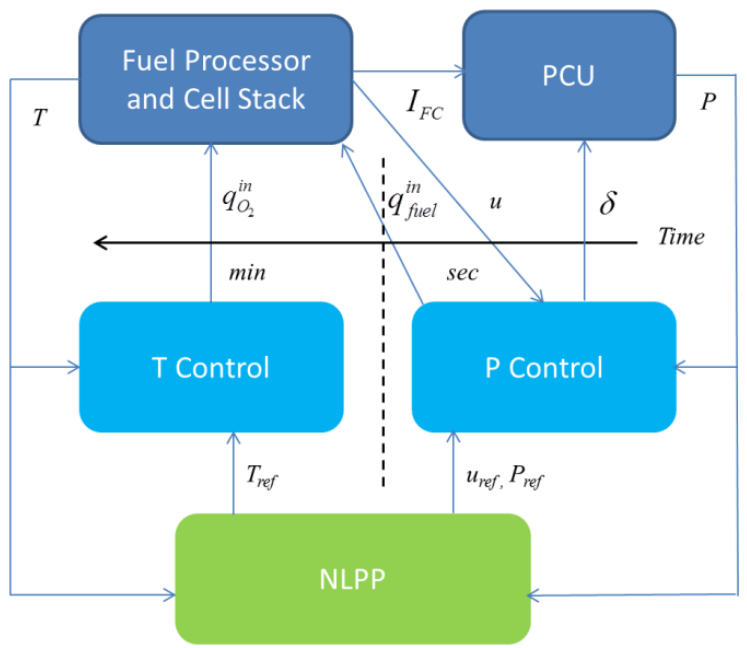
Figure 4. Diagram of the hierarchical control